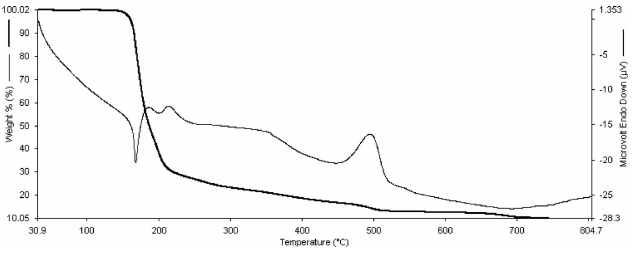
Figure 8 Simultaneous TGA–DTA analyses for 1 . The heavy (darker) lines show the TGA plot with the DTA behaviour shown by the lighter